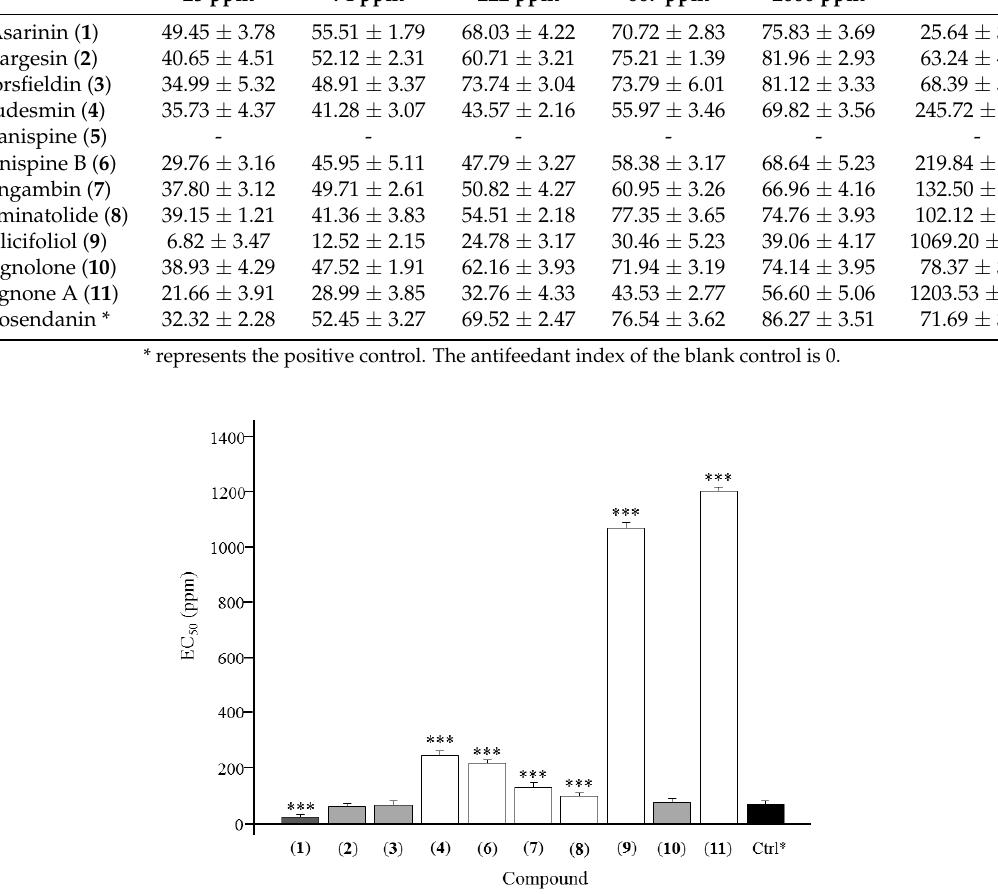
Table 1. Antifeedant activities of lignans from stem bark of Zanthoxylum armatum . Compound